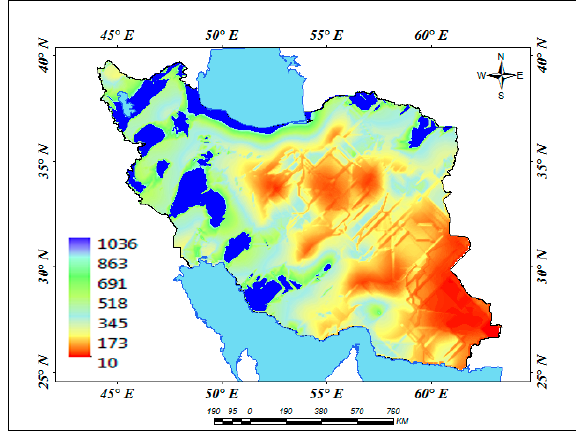
Figure 23. Forecasting of rainfall by using linear multi-regression.